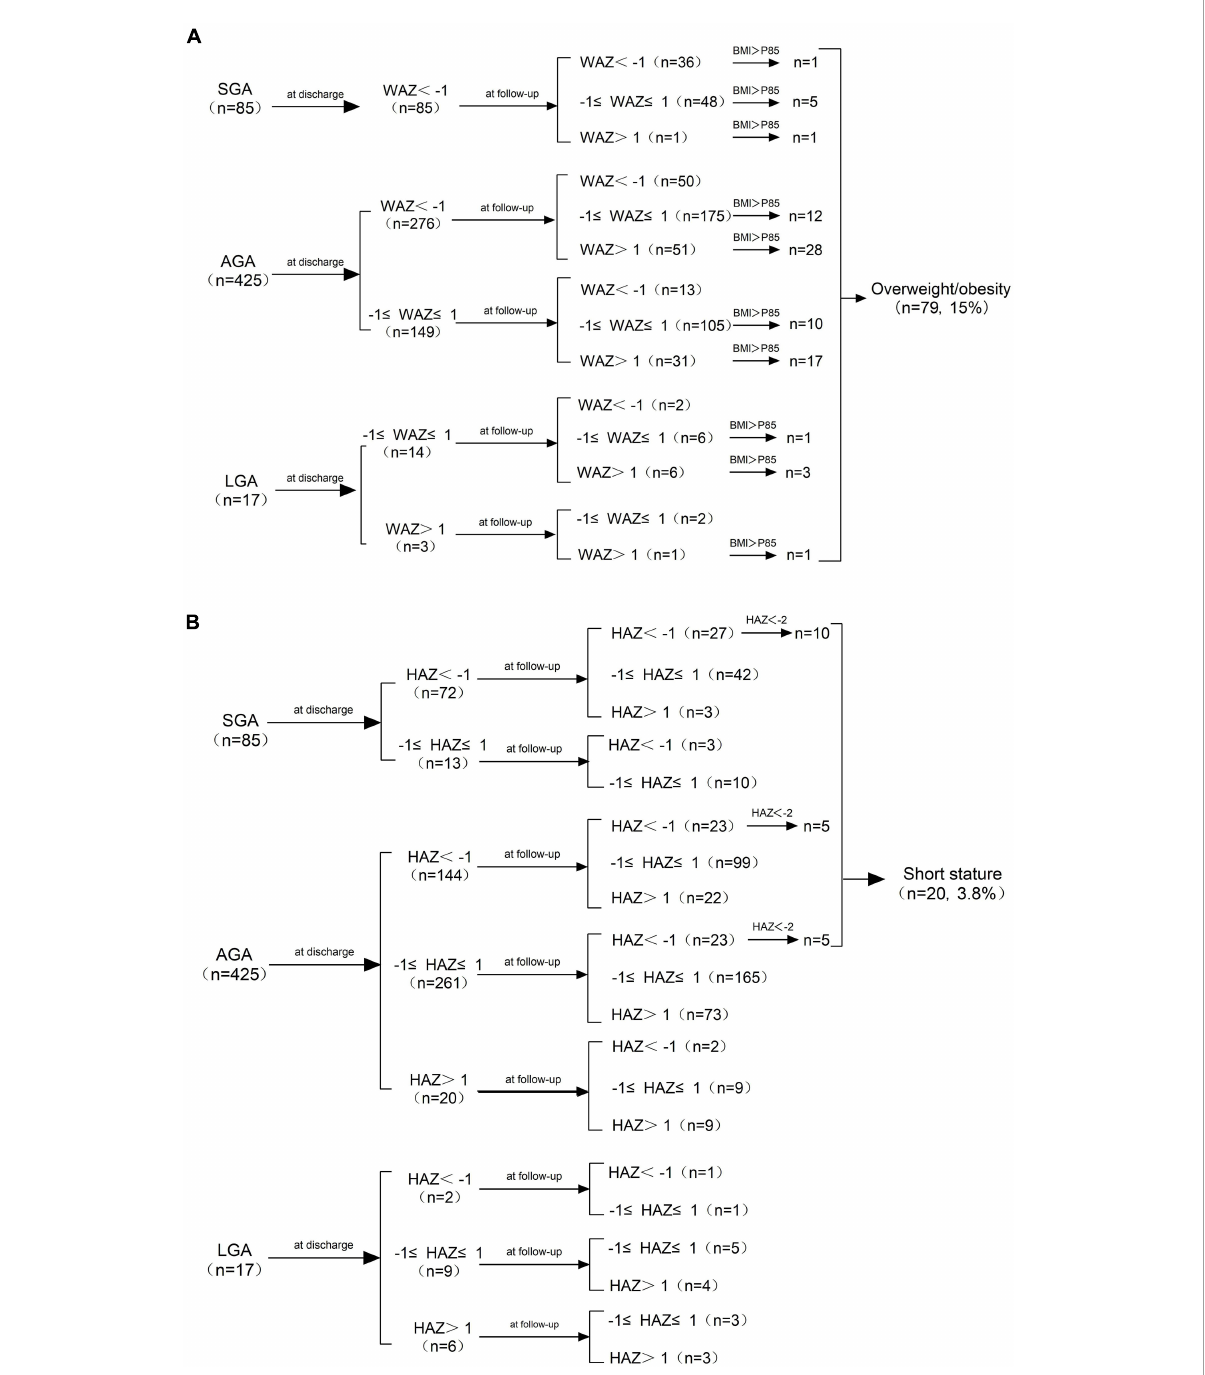
FIGURE2 (A) Changes in WAZ from birth to age 3 − 6 years and the distribution of overweight/obesity at follow-up. (B) Changes in HAZ from birth to age 3 − 6 years and the distribution of short stature at follow-up. SGA, small for gestational age; AGA, appropriate for gestational age; LGA, large for gestational age; WAZ, weight-for-age Z-score; HAZ, height − for − age Z − score; BMI, Body Mass